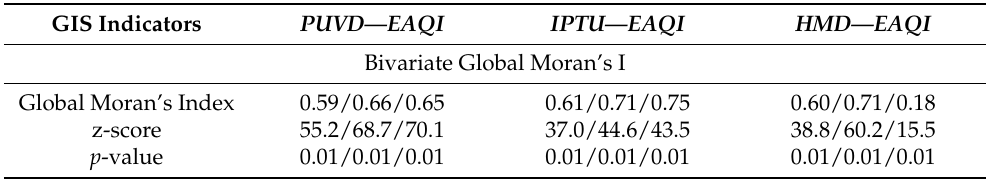
Table 1. Bivariate Global Moran’s I statistics for spatial correlation between mobility indicators and